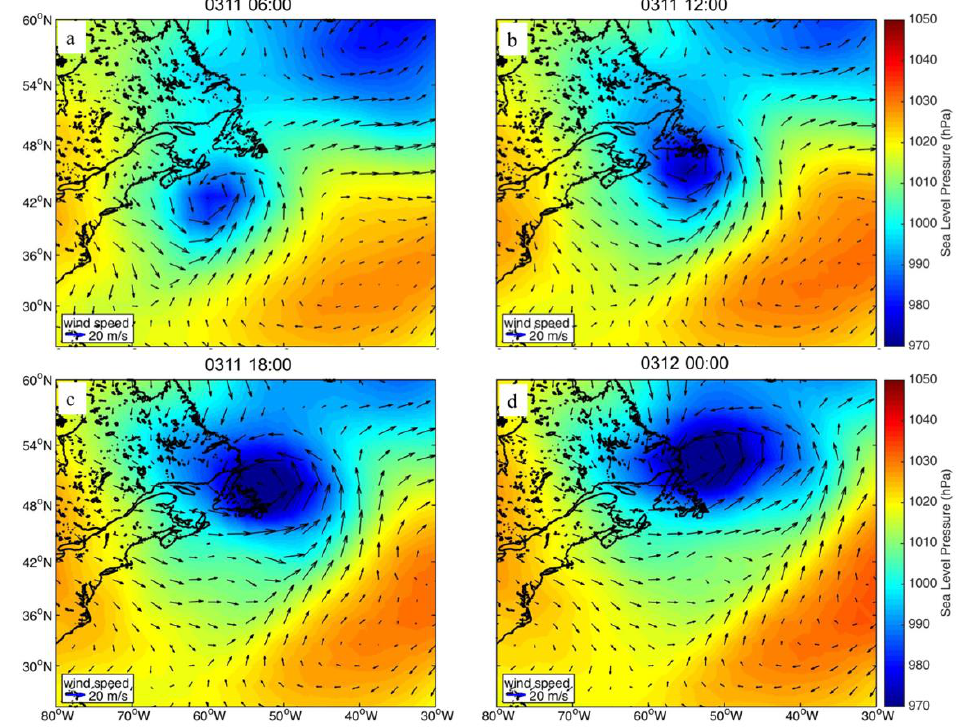
Figure 3. Wind fields (vectors) and sea level pressure (shadows) from CFSv2.